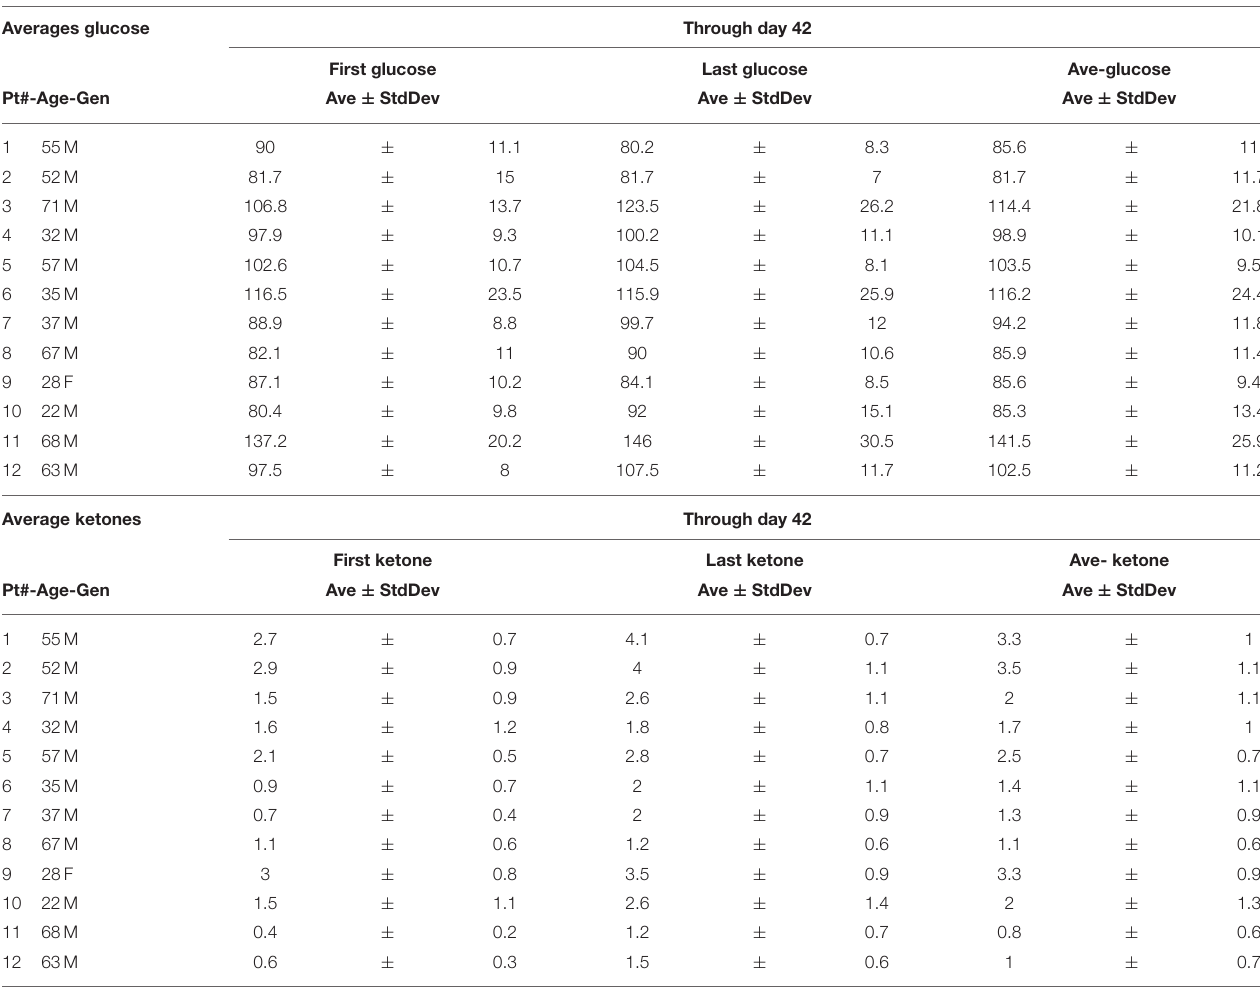
TABLE 1 | Blood glucose and ketones: first and last days and averages. Averages glucose Through day 42 First